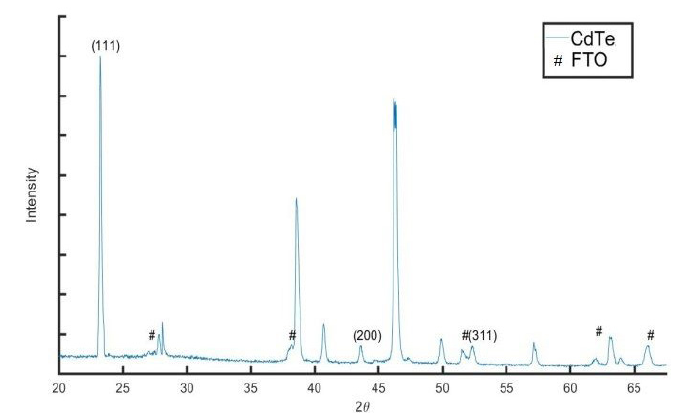
Figure 3. CdTe film diffractory on FTO substrate. Source the author.